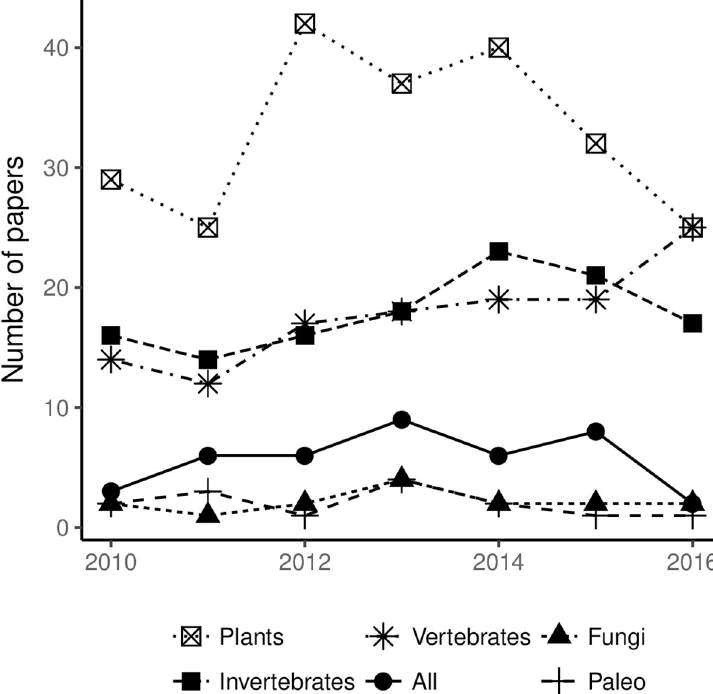
Fig 3. Number of papers addressing the major taxonomic groups and paleontological records over time.